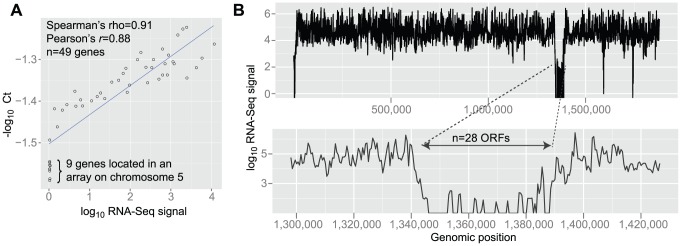
A non-transcribed region on chromosome 5.(A) Correlation of RNA-seq and RT-qPCR gene expression measurements for 49 genes in WB. Black dots are genes. The x- and y-axes show log10 FPKM and −log10 Ct (cycle threshold). Values were incremented by 1 before log10-transformation. Each RT-qPCR reaction was performed in triplicates, and the average Ct was used. The blue line is the linear regression (y = 0.07008x-1.50276). Included genes (prefix GL50803_): 7766, 9662, 6744, 7760, 112103, 11654, 11118, 2661, 24321, 17121, 17585, 14993, 16924, 13272, 6564, 5800, 3367, 17570, 16343, 93548, 11540, 5435, 15000, 21423, 10297, 114210, 86681, 7573, 7715, 102438, 7243, 16438, 17291, 1903, 17495, 102978, 11642, 17539, 90575, 32674, 13091, 137688, 3666, 25075, 16690, 2633, 92664, 13627, 4431. (B) Sliding window analysis of RNA-seq coverage on scaffold CH991767 (part of chromosome 5; WB). Analyzed windows were 500 bp wide and not overlapping. (X-axis) Position along the genomic segment (start position of the analyzed window). (Y-axis) RNA-seq depth in the window on a logarithmic scale. Drop in the RNA-seq coverage is seen in positions 1,340,000 to 1,381,000.